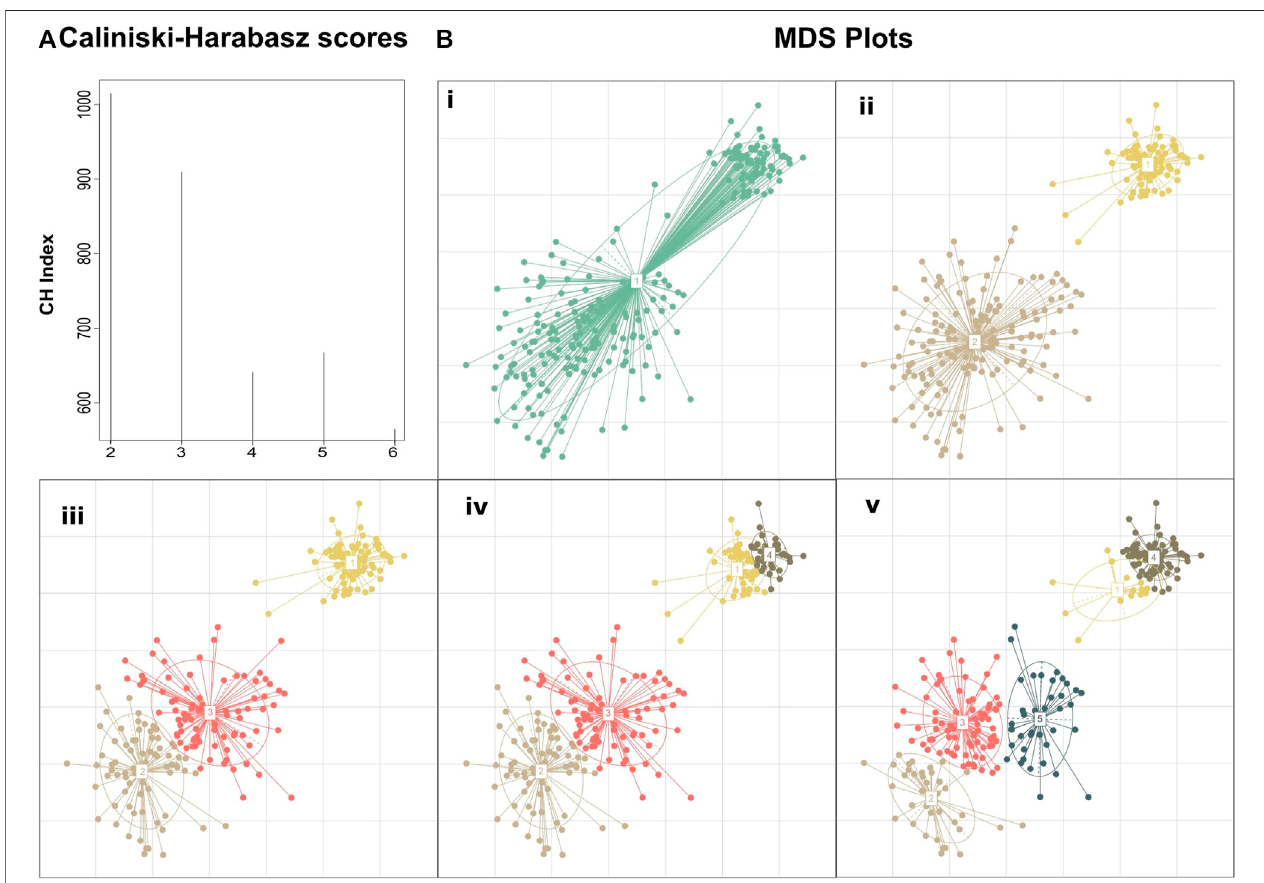
FIGURE 1 | Clusteringperformedonamanuallycreateddatasetdemonstratingtheaddedinsightonthestructureachievedbyselectingthenumberofclustersbased on clustering quality drop rather than simply using the clustering with the maximum score. (A) Calinski – Harabasz indexes calculated for PAM clustering with k ranging from 2to6.Althoughk =2showsthehighestscoresuggestingtheexistenceoftwoprimarygroupingsinthedataset,k=3also fi tswellintothedataset,revealingthecomposite natureofthesecondcluster.Furthersubclusteringresultsinalargedropintheclusteringqualitysuggestingthatthedatasetdoesnot fi twelltothenumberofclusters (B) MDS plots of the dataset at different de novo clustering levels (i) MDS plot of the unclustered dataset, (ii – v) PAM clustering of the dataset for k = 2 –